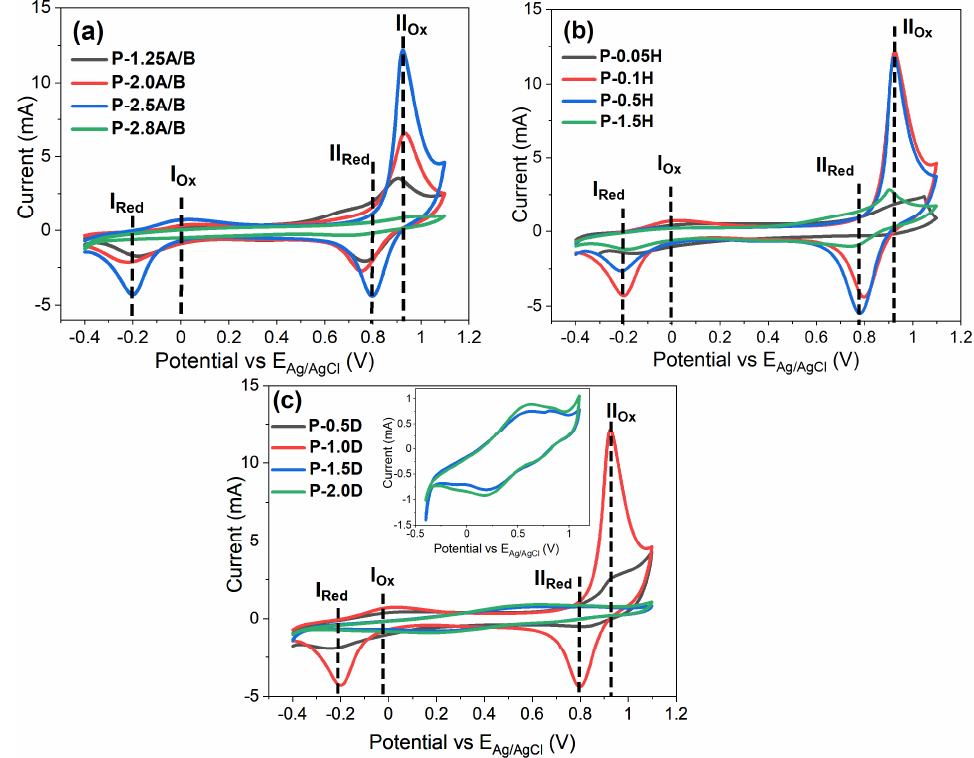
Figure 6. CV plots of Pbp coated gold electrodes from ( a ) P ‐ 1.25A/B to P ‐ 2.8A/B, ( b ) P ‐ 0.05H to P ‐ 1.5H, ( c ) P ‐ 0.5D to P ‐ 2.0D at 100 mV s − 1 in 1 M H 2 SO 4 . Inset: CV of P ‐ 1.5D (blue) and P ‐ 2.0D (green).